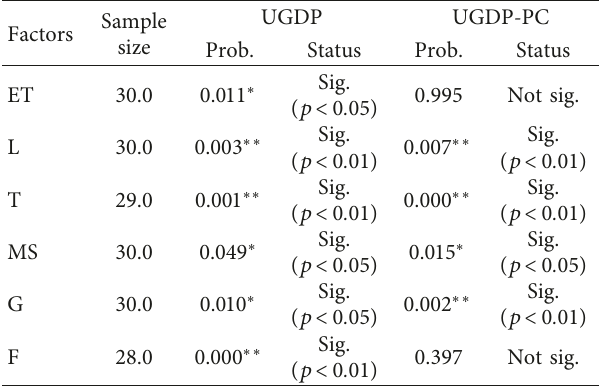
Table 2: The analysis of variance test for UGDP and